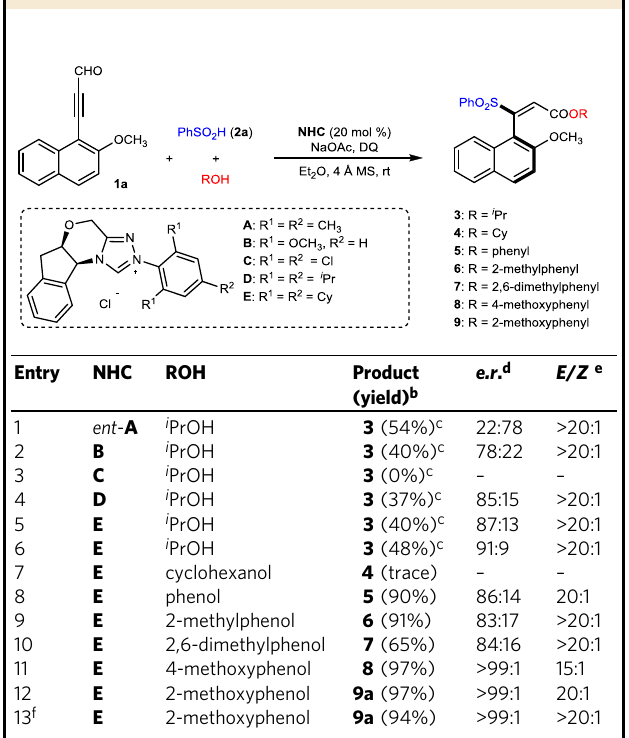
Table 1 Optimization of the reaction conditions a